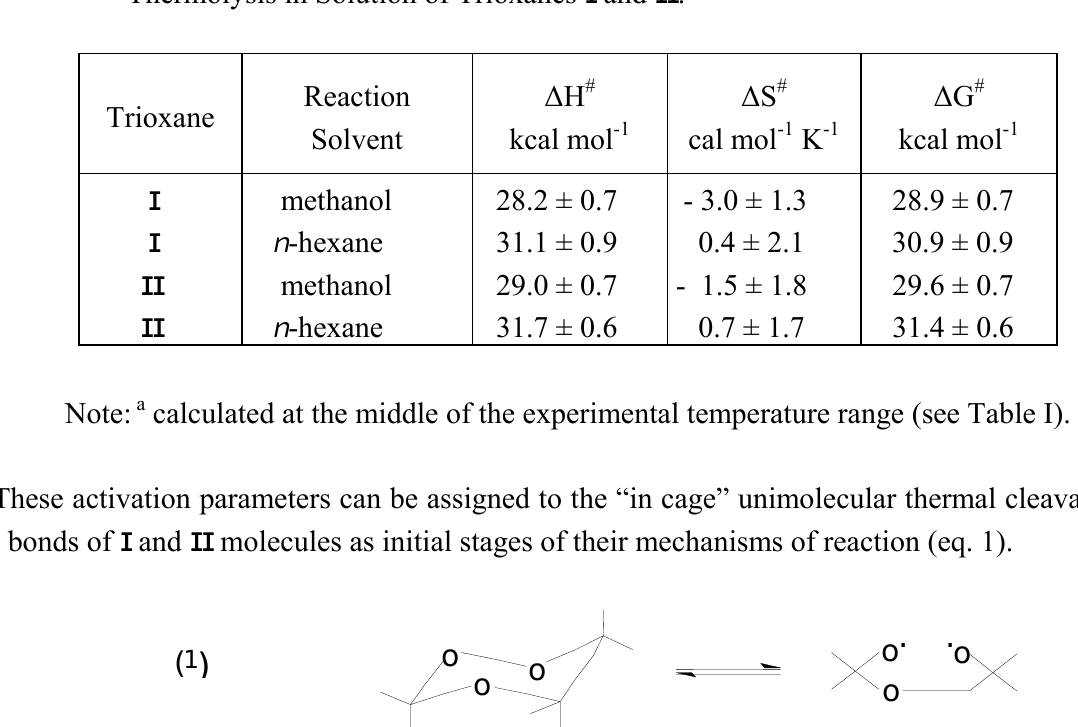
Table II . Activation Parameters Values a for the Unimolecular Thermolysis in Solution of Trioxanes I and II .